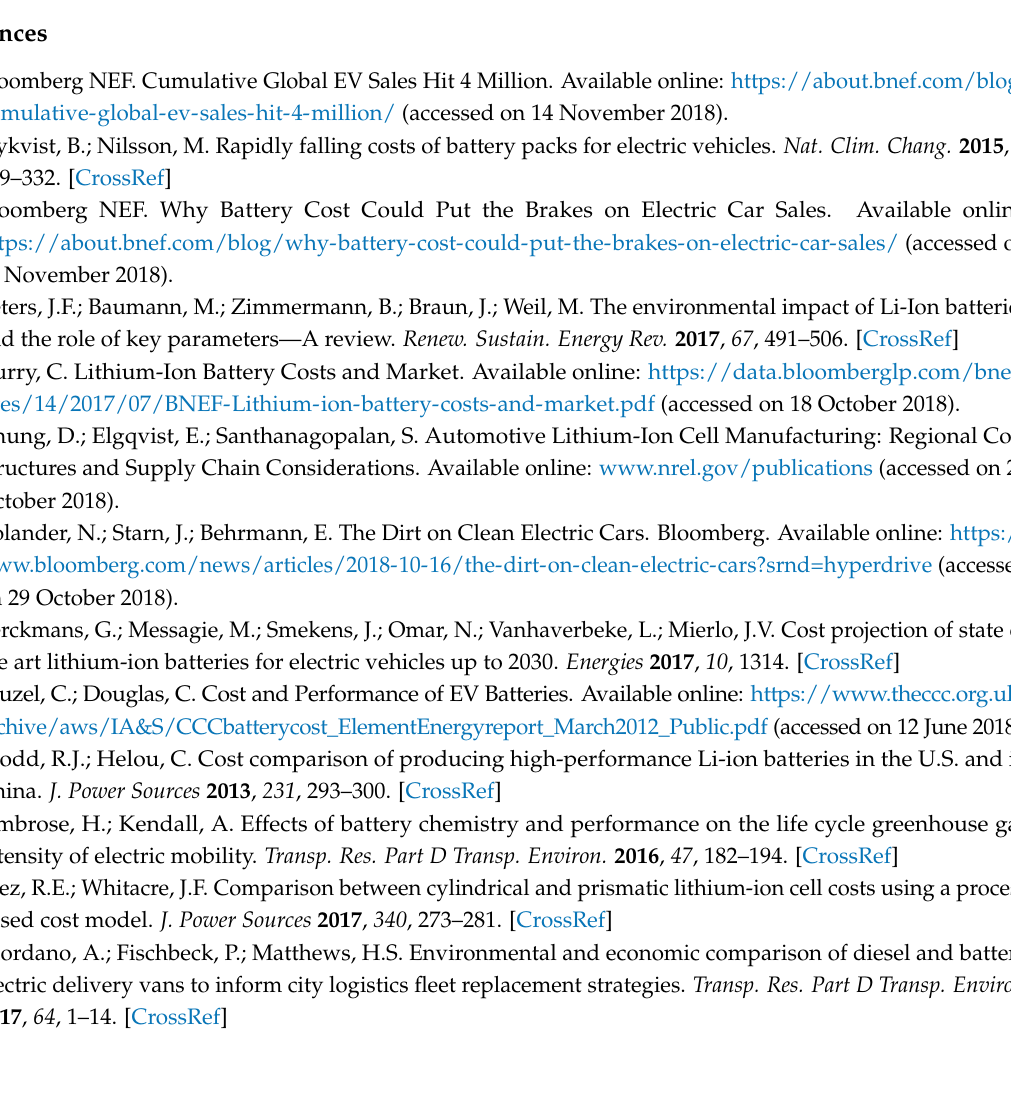
s1, Table S1: Inventory for the manufacturing of a pack manufactured in Korea, Table S2: Inventory for the manufacturing of cells in Korea, Table S3: Inventory for the manufacturing of the cathode paste, Table S4: Inventory for the manufacturing of the cathode active material, Table S5: Inventory for the manufacturing of NCA precursor, Table S1: Inventory for the manufacturing of the anode paste.